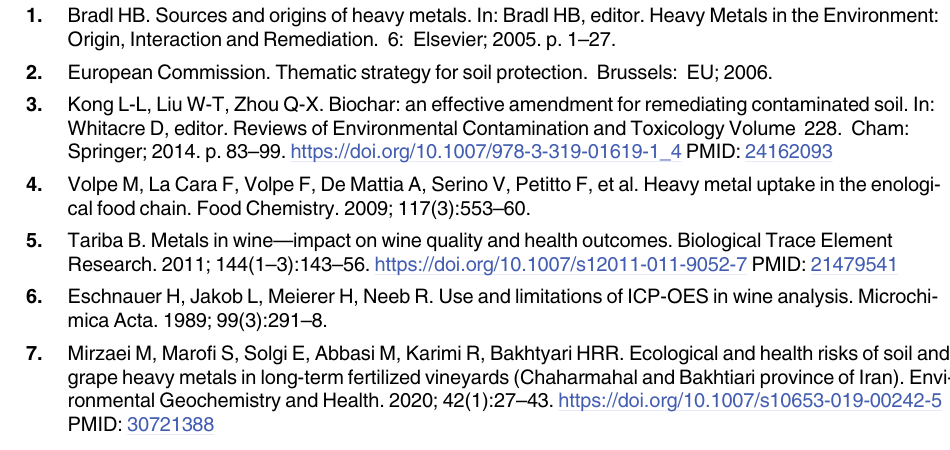
S1 Table. Elemental analysis of organic (e.g TF1) vs conventional wine samples (e.g TF2) from each of the Canary Islands. Results are provided as means in ng/l followed by standard deviation. S2 Table. Limits of Detection (LoDs) for each examined element. Results are provided as means in